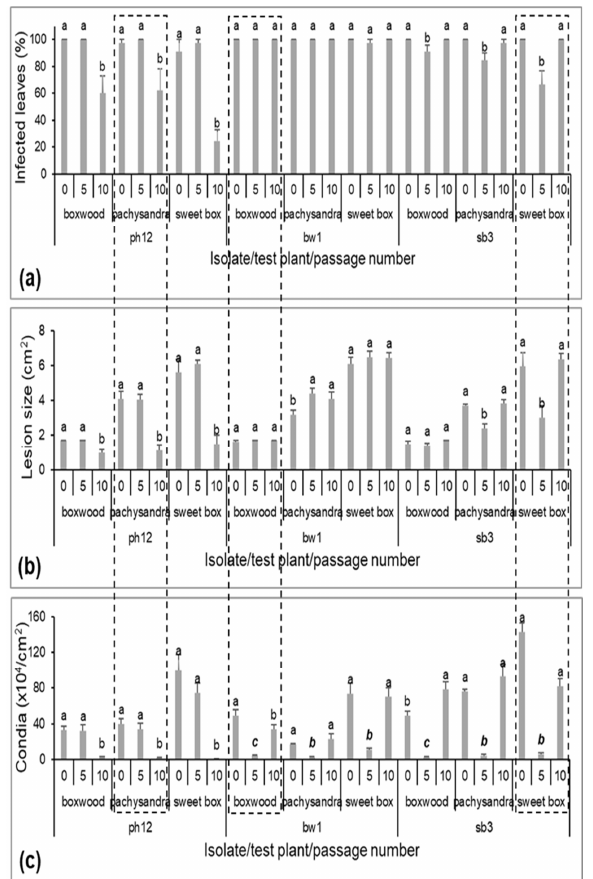
Figure 5. Comparison of aggressiveness components of selected Calonectria pseudonaviculata isolates before (P0) and after passages (P5 and P10) on di ff erent hosts. Infected leaves ( a ), lesion size ( b ), and conidial production ( c ) were assessed 14, 28, and 10 days after inoculation, respectively. Each column is an average of thirty leaves from three experiments. Columns are topped by a standard error bar and signi fi cance le tt er. For each isolate, columns from a single test plant topped with di ff erent le tt ers are signi fi cantly di ff erent, p ≤ 0.05. Columns within broken-line rectangles depict aggressiveness of isolates on their original hosts.